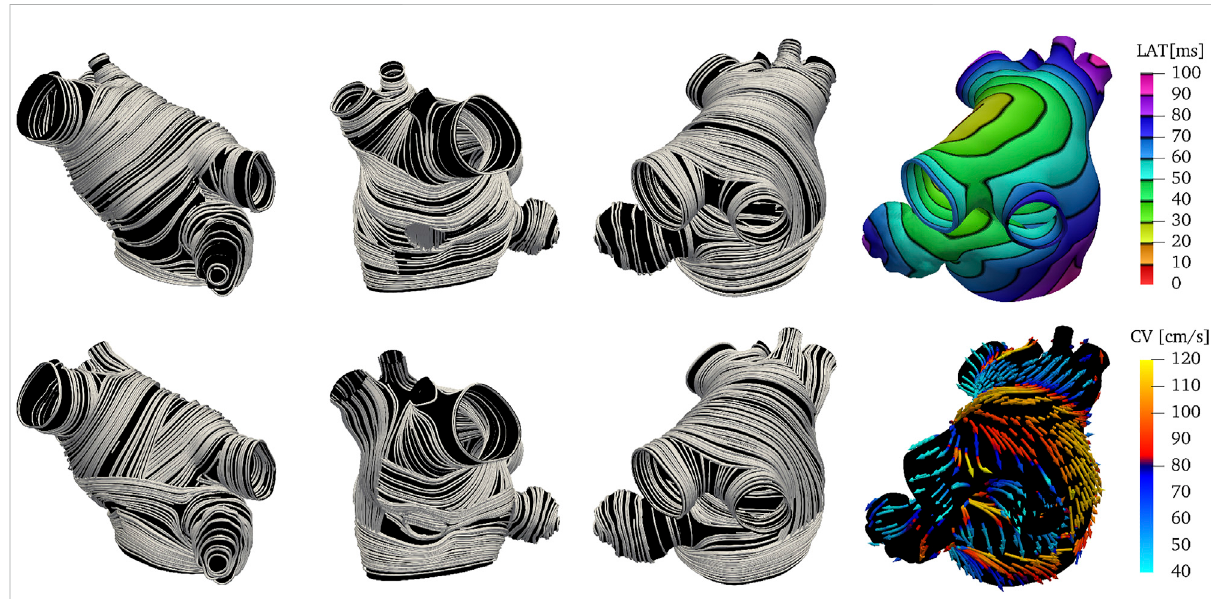
FIGURE 4 Endocardial (top) and epicardial (bottom) fi ber fi elds, activation times and conduction velocities on M75. The Bachmann ’ s bundle on the epicardiallayerwrapsaroundtheleftatrialappendage.Notethattheorientationofthe fi bersintheleftandrightcarinaandintheleftlateralridgeare an improvement over existing methods in representing the anatomical muscle bundles. Similarly to Fastl et al. (2018), the fi bers in the right posterior pulmonary veins are set longitudinally instead of circumferentially. The activation times and the conduction velocities show two main paths of activations: one circumferential through the Bachmann ’ s bundle and another superior and then posterior through the septoatrial